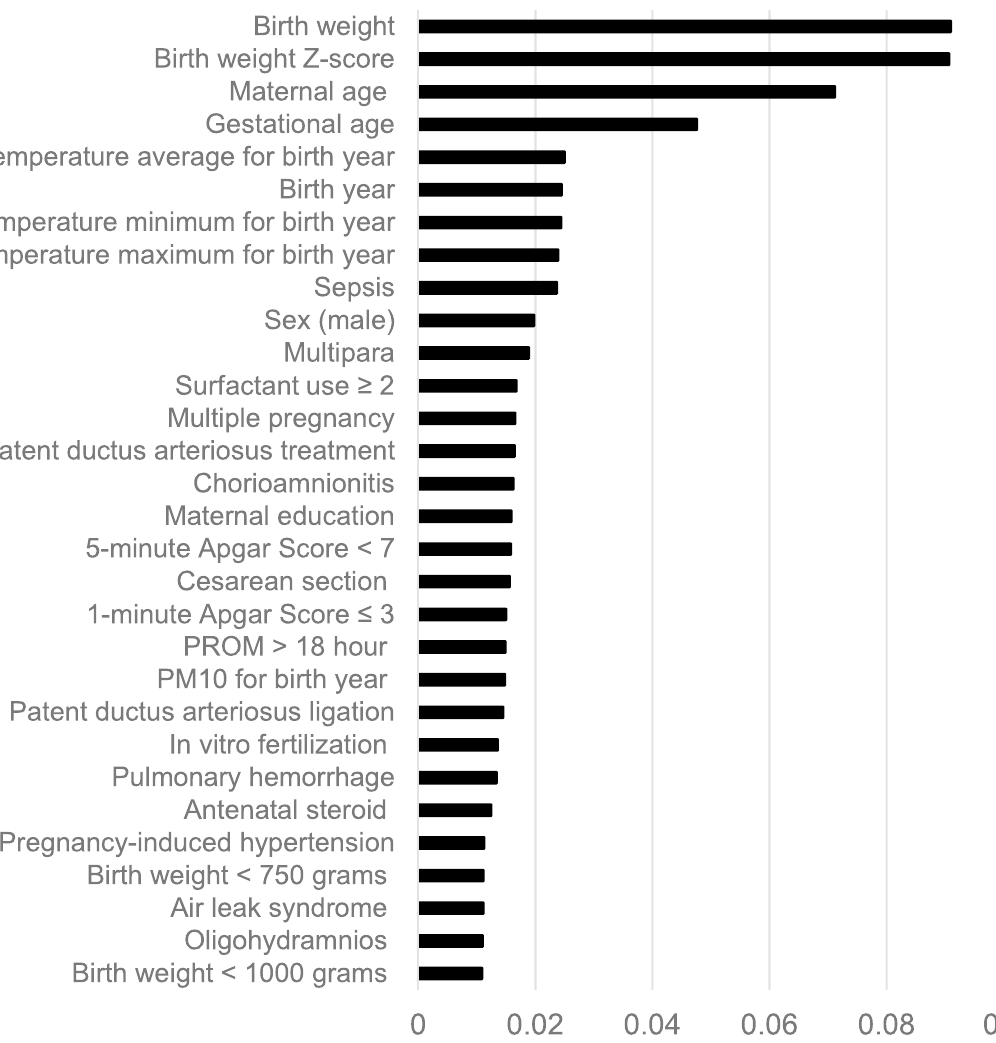
Figure 2. Random Forest Variable Importance Plots for Necrotizing Enterocolitis. Legend: Random forest variable importance calculates node impurity (GINI) decrease from the creation of a branch on a certain predictor. It is an average over all trees in a random forest with the range of 0 and 1. Abbreviations: PM, Particulate matter; PROM, Pre-labor rupture of